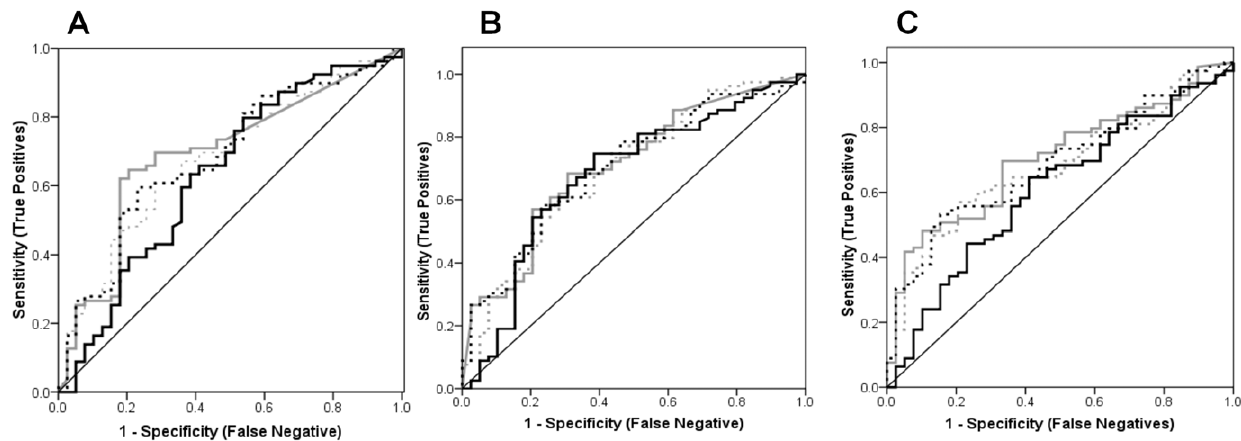
Figure 4. AUROC for IL-6, IL-8 and VEGF. The lowest area under receiver operating characteristic (AUROC) were determined after protein normalization as represented by the solid black curve which was always closest to the diagonal reference line i.e., IL-6=0.634 (0.523 to 0.745); IL- 8=0.677 (0.570 to 0.784); and VEGF=0.609 (0.501 to 0.716). The AUROCs for uncorrected biomarker levels (thick grey curve), and those standardized using osmolarity (dashed black curve) or creatinine (dashed grey curve) were very similar for individual biomarkers : (A) IL-6=0.693 (0.592 to 0.794), 0.683 (0.582 to 0.784) and 0.678 (0.578 to 0.779), respectively; (B) IL-8=0.706 (0.608 to 0.804), 0.701 (0.603 to 0.799) and 0.694 (0.592 to 0.795), respectively; and (C) VEGF=0.705 (0.610 to 0.799), 0.687 (0.591 to 0.783) and 0.680 (0.583 to 0.777), respectively. Figures in brackets are 95% Confidence Intervals.